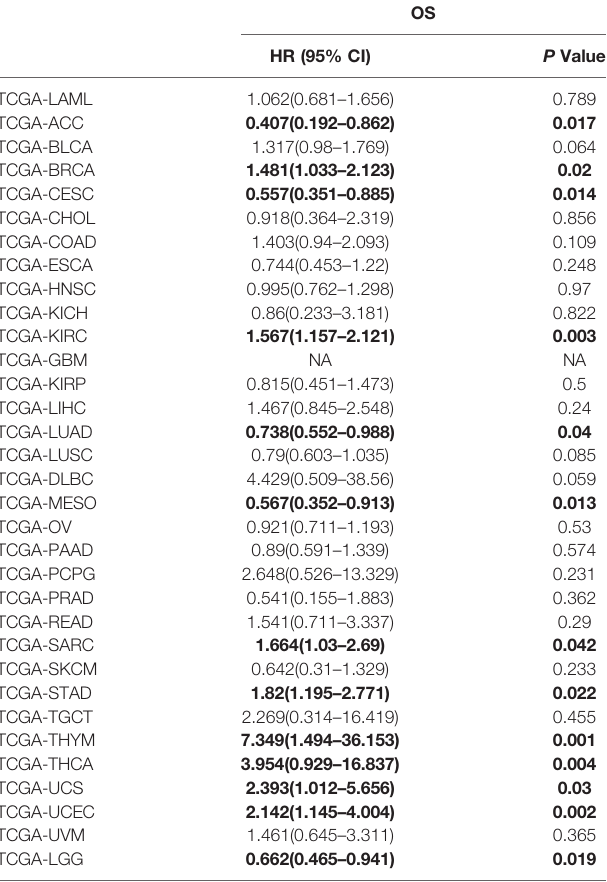
TABLE 7 | HRs and corresponding 95% CIs of SOX2-OT overexpression in tumors based on The Cancer Genome Atlas (TCGA) datasets. OS HR (95%